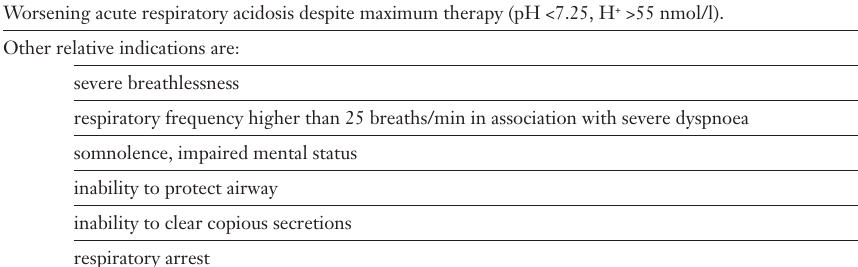
Indications for inva- sive mechanical